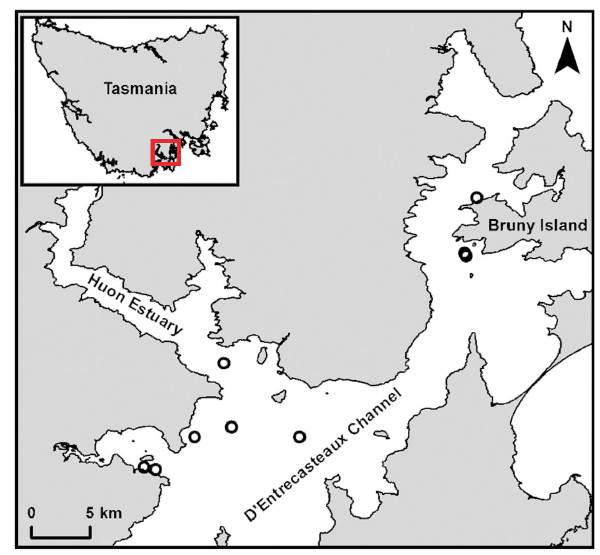
Fig. 1. Location of the 9 salmon cages sampled (open circles) in upper and lower sections of the D’Entrecasteaux Channel, situated in southeast Tasmania (inset). Note that 2 circles overlap for cages close together off Bruny Island